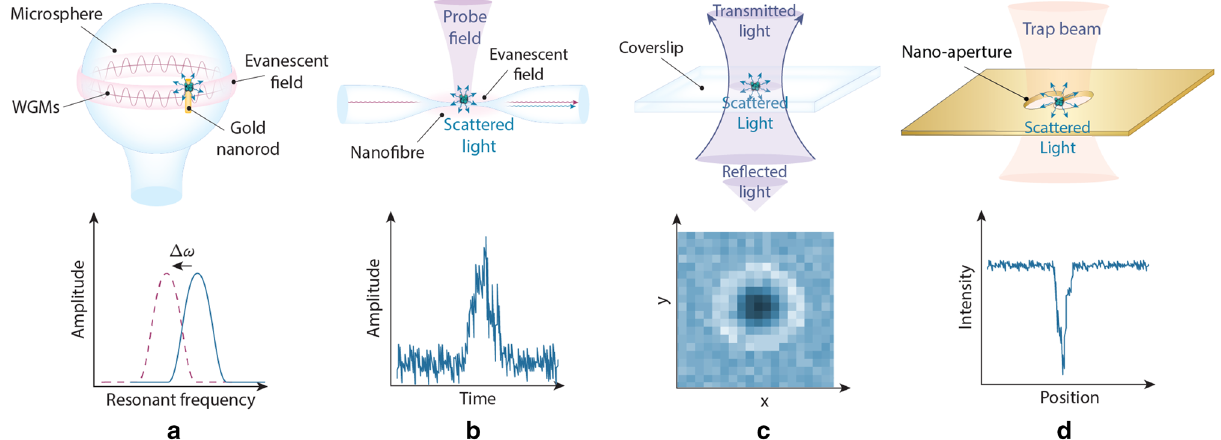
Figure 1. Single-molecule biosensors and their corresponding signals measured. ( a ) Optoplasmonic sensors use a shift in a cavity resonance frequency to detect the presence of a molecule 5 , ( b ) dark-field heterodyne microscopy collects the scattered field from a biomolecule and measures the beat-note of this field with light at a slightly different frequency 4 . ( c ) Interferometric scattering microscopy (iSCAT) uses the interference between the light reflected from the glass cover slip and the light scattered from the molecule to construct an image of the molecule 6 . ( d ) Plasmonic tweezers monitor the intensity of light transmitted through a sub-diffraction-limited hole in a plasmonic structure as a biomolecule enters the hole 11